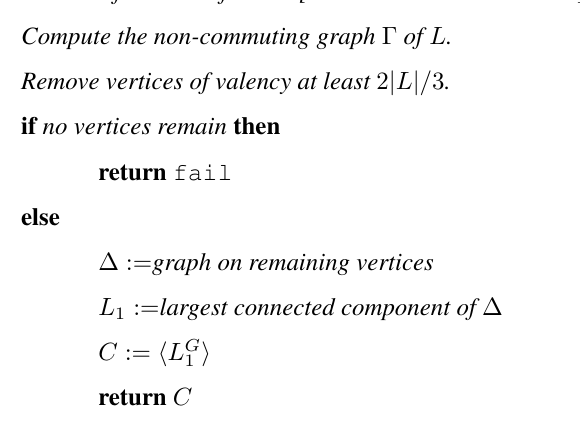
Algorithm 3.5 (P ROCESS L IST